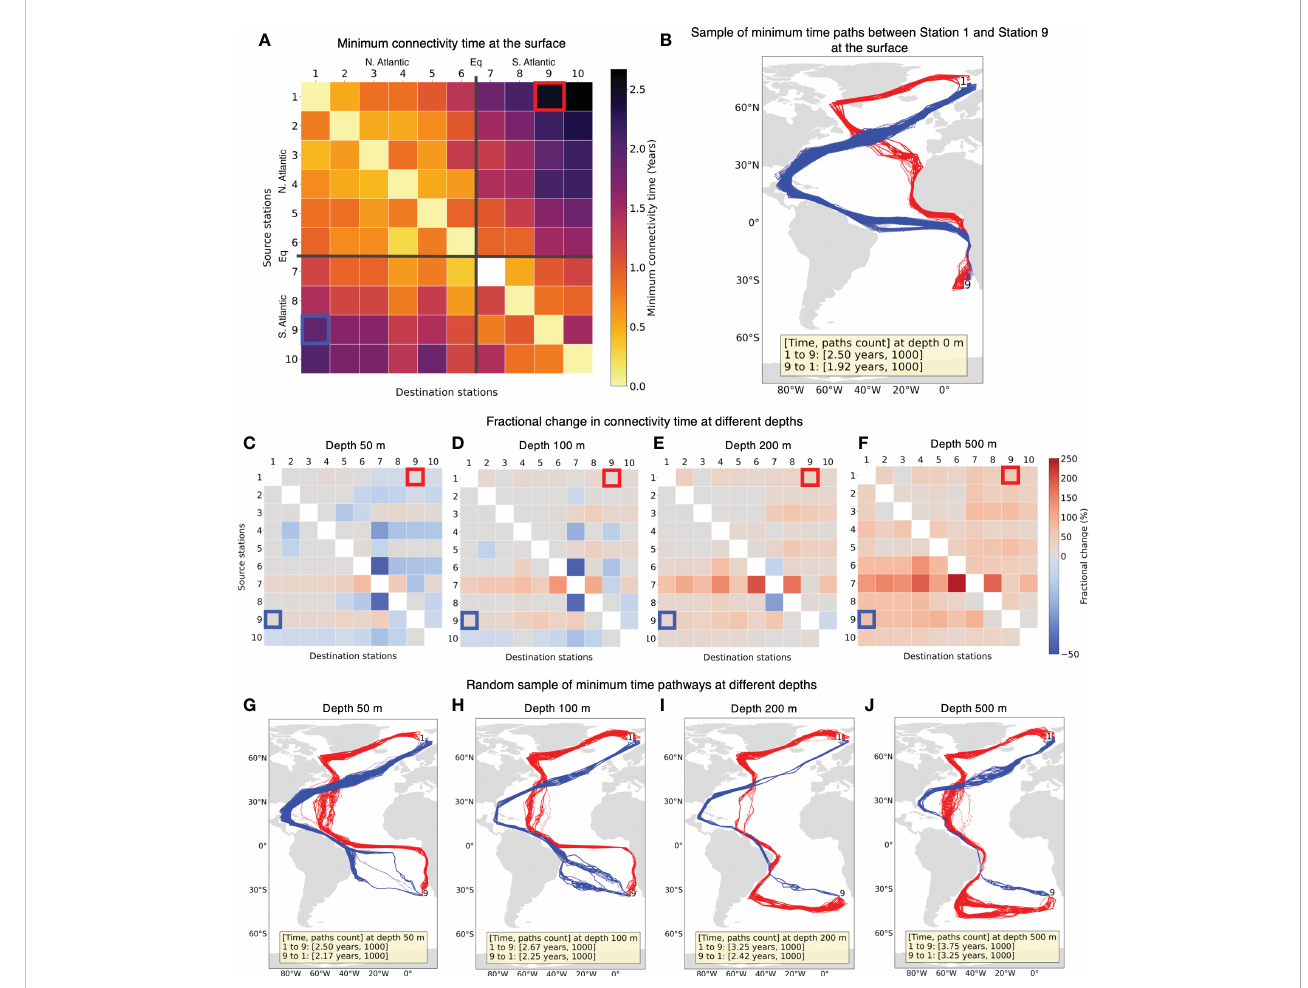
FIGURE 4 (A) Minimum connectivity time at the surface for non-constrained particles connecting source stations to destination stations. The stations are in the ascending order of their latitudes. (B) Example of random sample of minimum time connectivity paths at the surface between Station 1 and Station 9. Paths from Station 1 to 9 are indicated in red and from Station 9 to 1 are in blue . These paths are obtained by joining grid cell locations every 30 days, hence some paths may appear to cut across land. (C – F) The fractional change in connectivity time for depths 50, 100, 200 and 500 m, respectively compared to the surface connectivity time in (A) . Colors in red tone indicate increase in connectivity time at a given depth while blue indicate decrease in connectivity time. (G – J) Random sample of minimum connectivity time pathways between the same two stations as (B) and depths same as the row